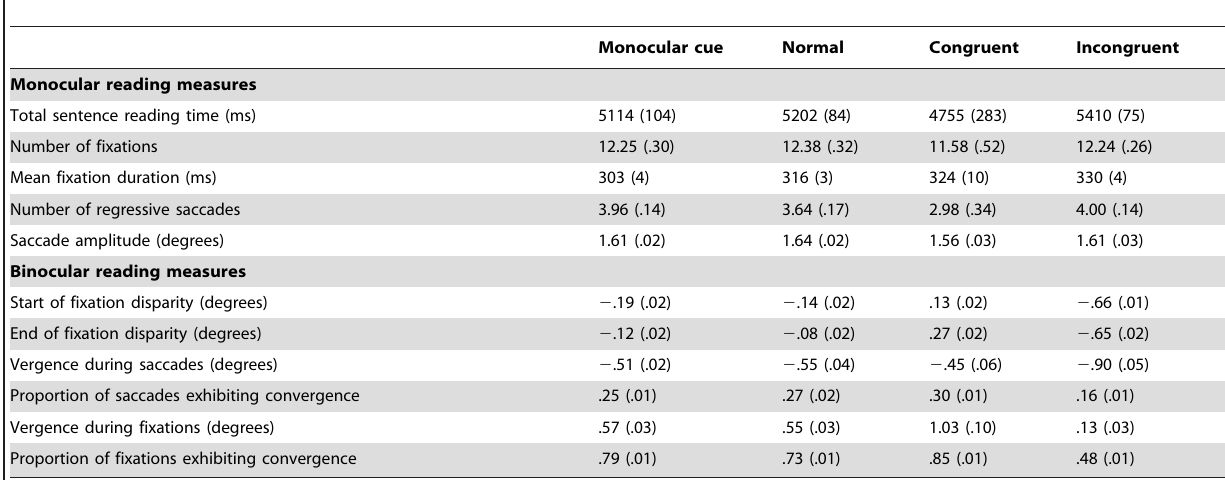
Table 1. Means and standard errors for monocular and binocular dependent measures in each of the four experimental